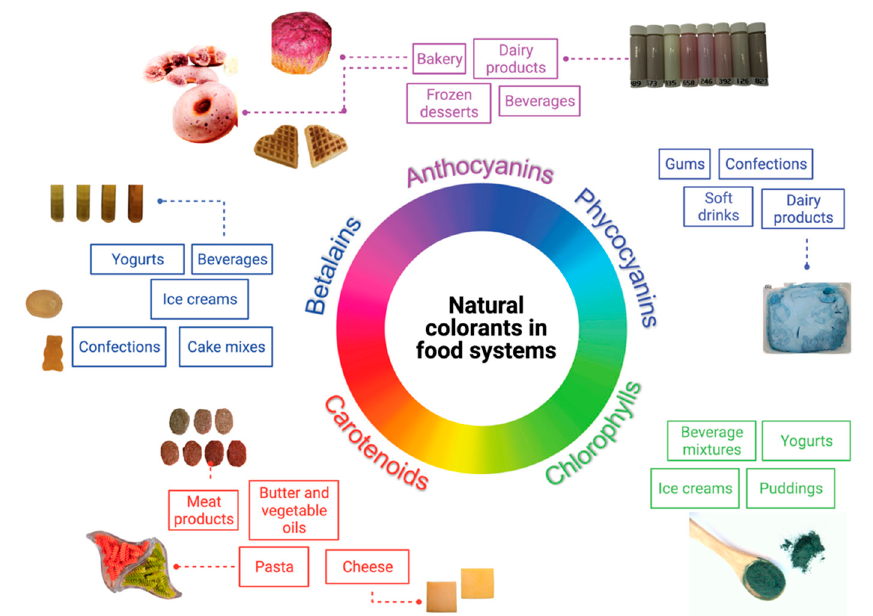
Figure 2. Natural colorants in food systems. Figures reprinted from Abdel-Moemin et al. [73],